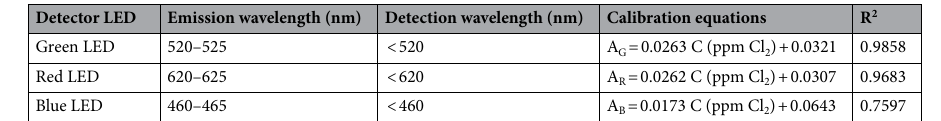
Table 2. A summary of the calibration curve equations obtained using the developed PEDD-based photometer in the concentration range of 0.5 to 20.0 ppm Cl 2 using different detector LEDs (conditions: 200 μL DPD reagent and 500 μL buffer solution of pH 6 were added to appropriate sodium hypochlorite solution portions). Then, 2.5 mL milk samples were added to the mixture and the mixtures were diluted to the final volume of 5.0 mL using deionized water. For the PEDD-based photometer, the applied voltage was 2.8 V.